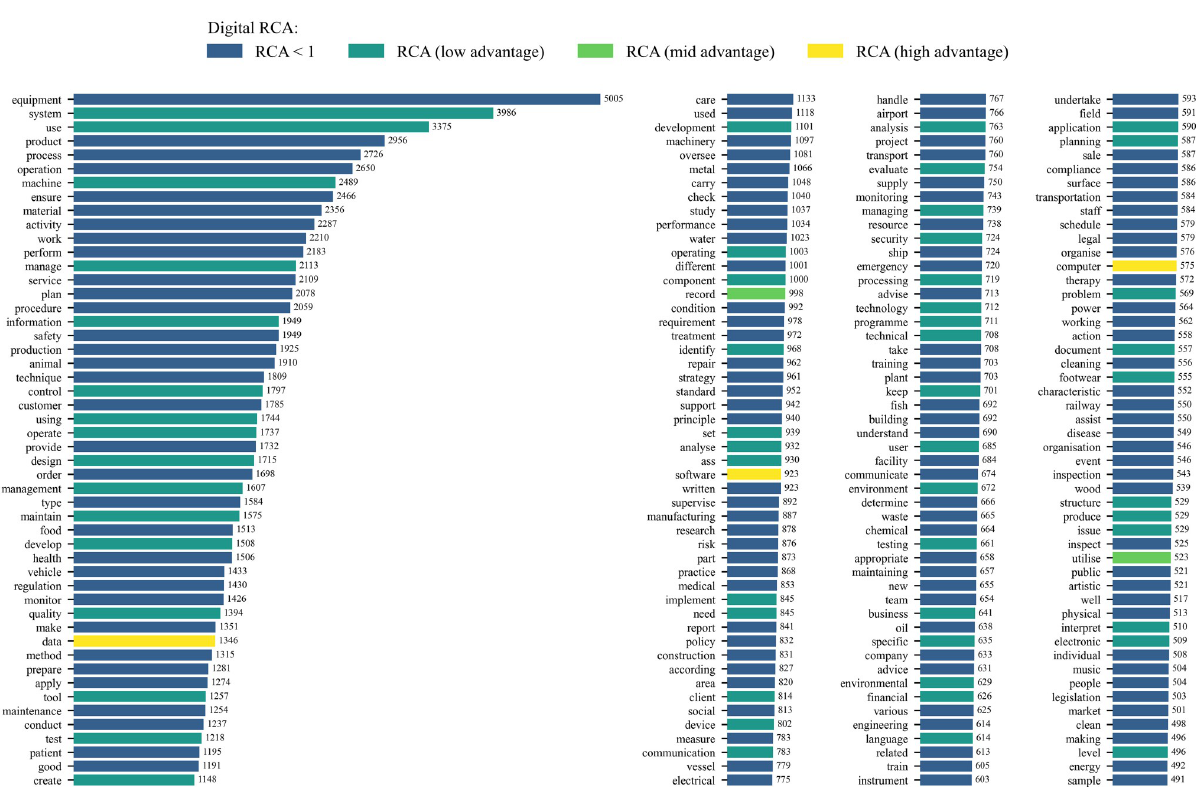
Fig 1. Text analysis: Most frequent terms and RCA of terms. Note 1: term counts based on the label, alternative labels and the description of skills. Note 2: a RCA < 1 means that the term is less frequent among digital skills relative to all skills. Thus the term has a relative comparative ‘disadvantage’ describing digital skills. RCA (low advantage) for digital RCA between 1 and 5; RCA (mid advantage) for digital RCA between 5 and 10; and RCA (high advantage) for digital RCA greater than 10. Note 3: for the text analysis, we first tokenise the text, we then discard punctuation marks and stop-words such as ‘from’, ‘the’, and ‘further’, and finally, we apply a lemmatisation using Python NLTK package for Natural Language Processing